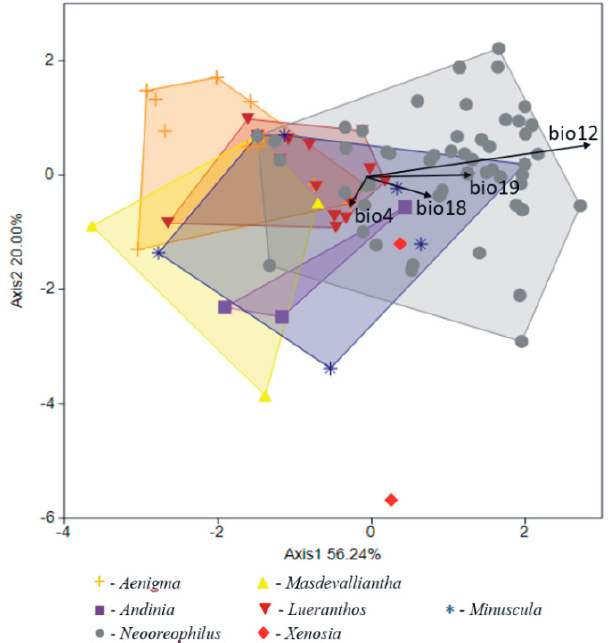
Figure 9. Canonical variate analysis (CVA) of the studied genera among the Andinia -complex along the climatic gradient. The relative contributions of bioclimatic factors are shown as vectors. Variables with low discriminating impact are omitted.